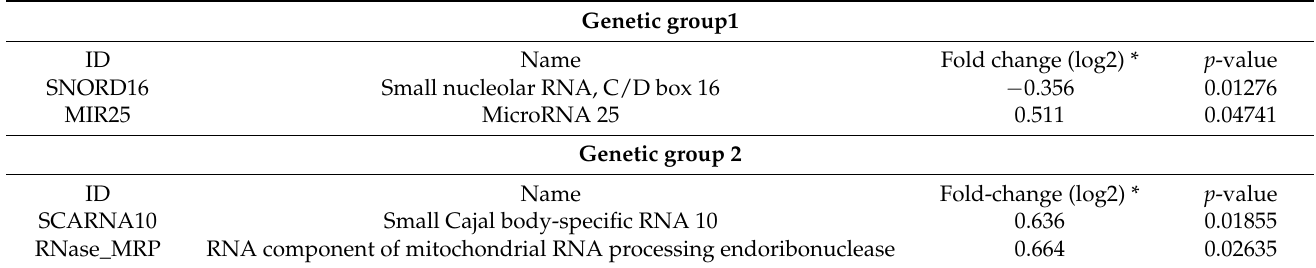
Table 2. The differential analysis of non-coding RNAs in G1 and G2.